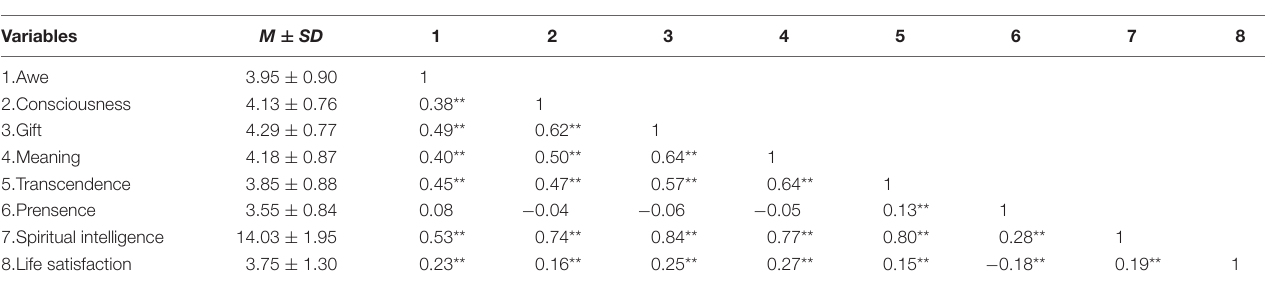
TABLE 2 | Means, standard deviations, and correlation coefficients of